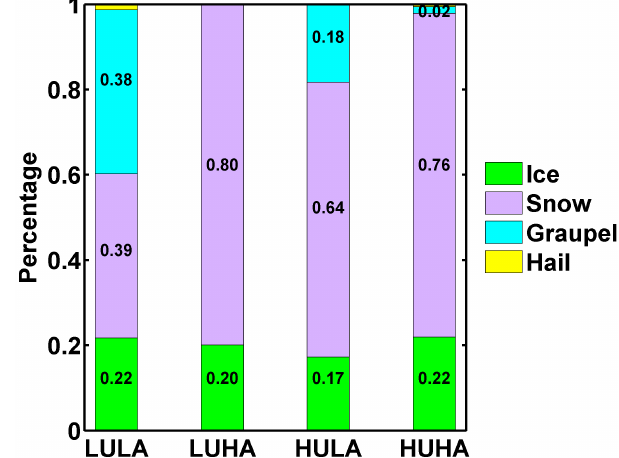
Figure 11. Contributions of individual frozen hydrometeor to to- tal frozen water content under four extreme conditions, which are referred to as (1) LULA: low updrafts (2000Wm − 2 ) and low aerosols (200cm − 3 ); (2) LUHA: low updrafts (2000Wm − 2 ) and high aerosols (100000cm − 3 ); (3) HULA: high updrafts (300000Wm − 2 ) and low aerosols (200cm − 3 ); and (4) HUHA: high updrafts (300000Wm − 2 ) and high aerosols (100000cm − 3